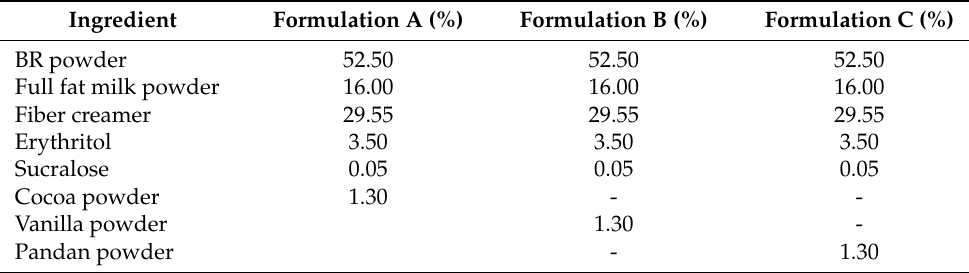
Table 1. Instant beverage formulations from BR powder in various